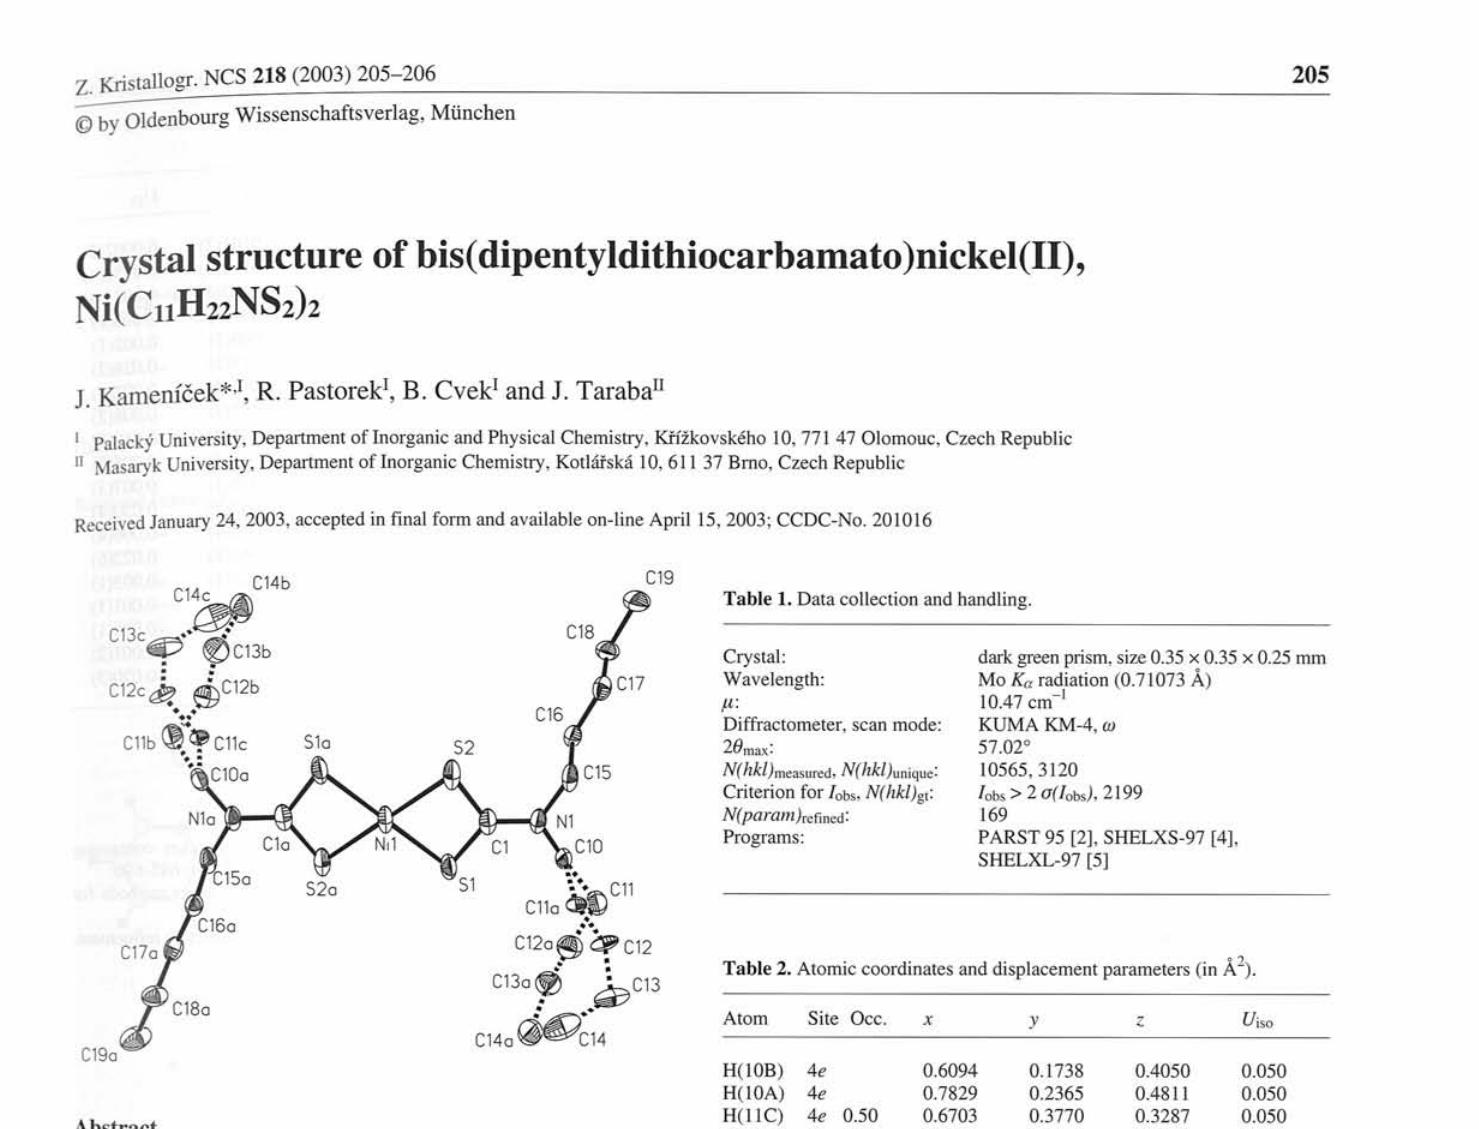
Table 2. Atomic coordinates and displacement parameters (in À